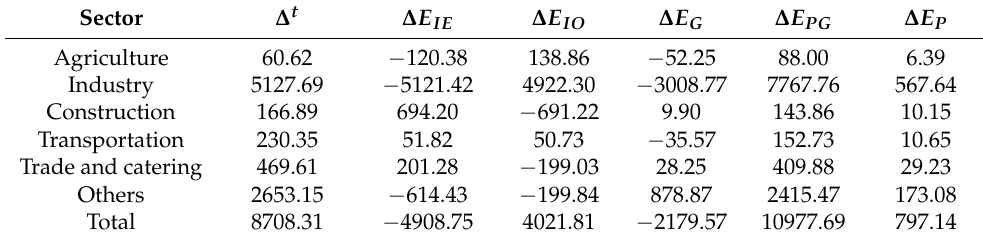
Table 4. Decomposition results of sectoral electricity consumption (10 8